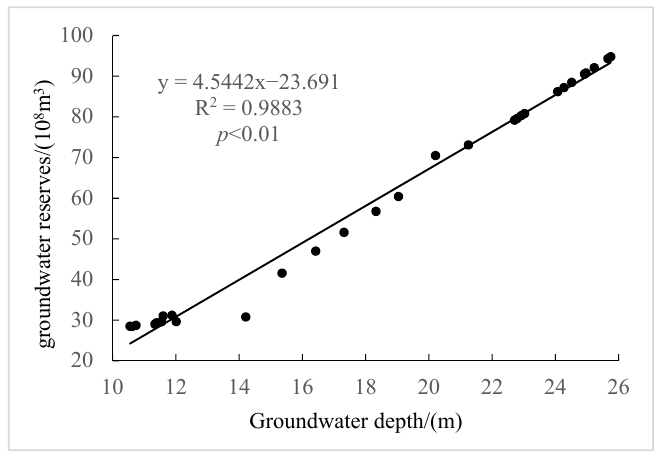
Figure 7. Correlation between groundwater depth and groundwater storage.